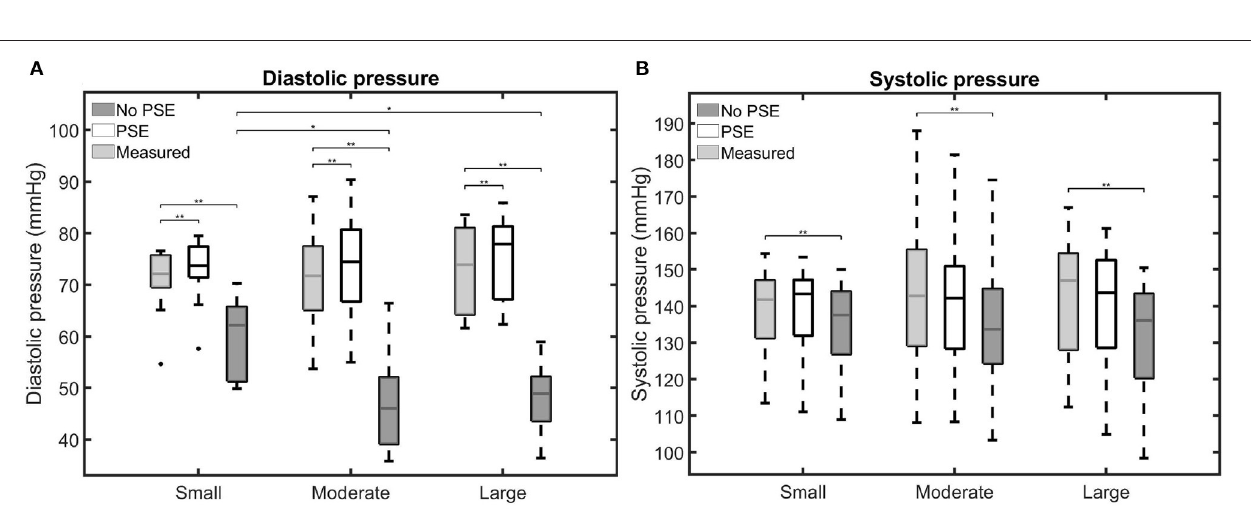
FIGURE 4 | Inlet (blue) and outlet (red) flow (left) and pressure (right) resulting from the FSI simulations with PSE (solid) and without PSE (dashed) for patient L8. Note that the inlet flow is similar for both simulations, since a generic inlet flow is prescribed.